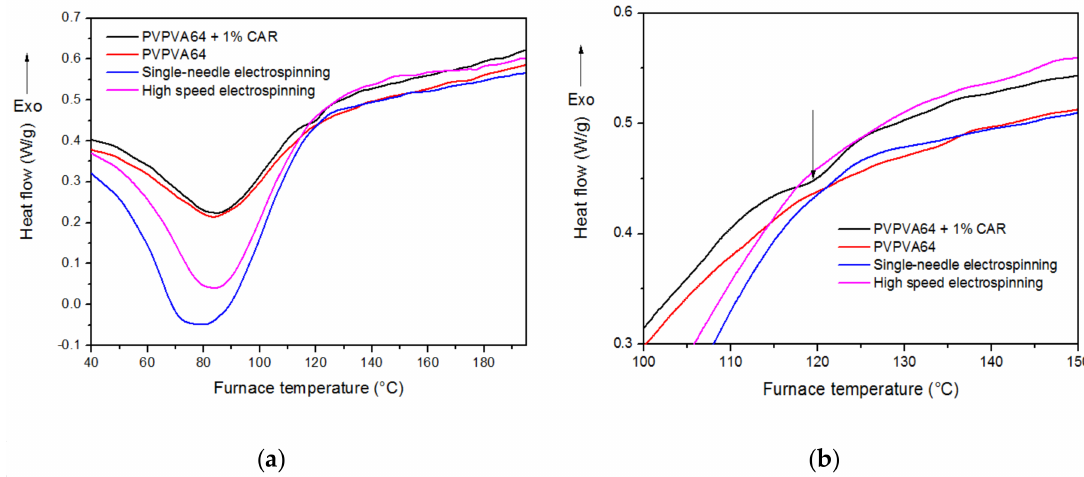
Figure 3. ( a , b ) Differential scanning calorimetry (DSC) thermograms of PVPVA64, PVPVA64 +